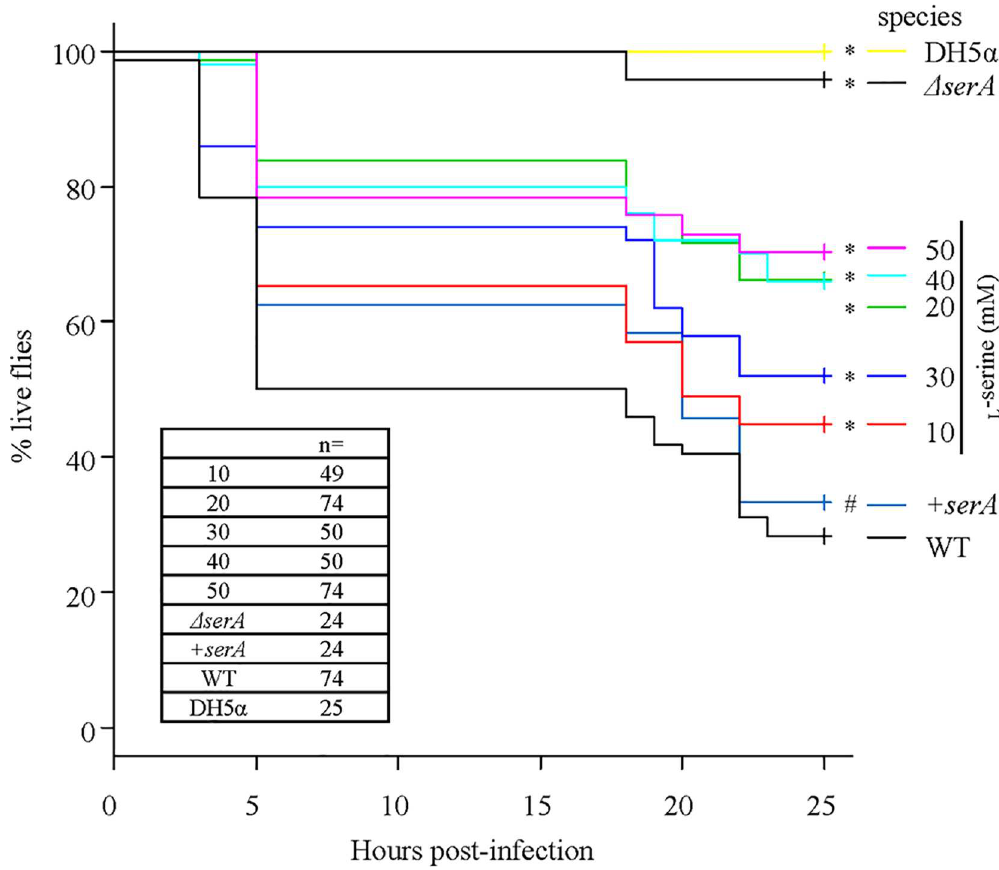
Fig 9. Fly survival experiments. Virulenceof the wild-typestrain (WT), PAO1Tn:: serA mutant ( Δ serA ),PAO1Tn:: serA (pUCP19- serA ) complementary strain (+ serA ), E . coli DH5 α (as a negativecontrol), and WT in the presenceof L -serine (10, 20, 30, 40, and 50 mM) was evaluated. Significantdifferences, basedon the log-ranktest, were observedbetweenWT and DH5 α ( * : P < 0.05), betweenWT and Δ serA ( * : P < 0.05), betweenWT and WT in the presenceof 50 mM L -serine ( * : P < 0.05), betweenWT and WT in the presenceof 40 mM L -serine ( * : P < 0.05), betweenWT and WT in the presenceof 20 mM L -serine ( * : P < 0.05), betweenWT and WT in the presence of 30 mM L -serine ( * : P < 0.05), and betweenWT and WT in the presenceof 10 mM L -serine ( * : P < 0.05). Virulenceof the + serA complementary strain was significantly restored as comparedto that of Δ serA (#; P <